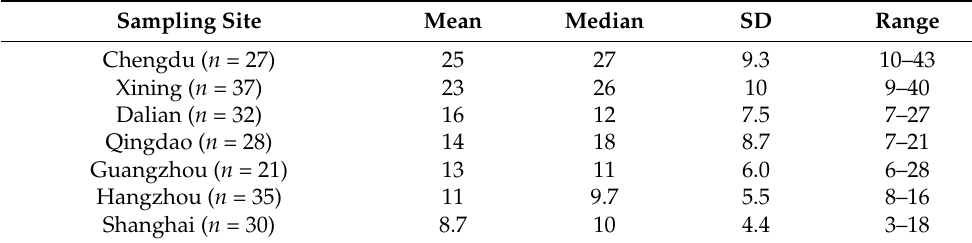
Table 1. Abundance (Items/TOFC) of MPs in TOFCs collected from Chinese cities.